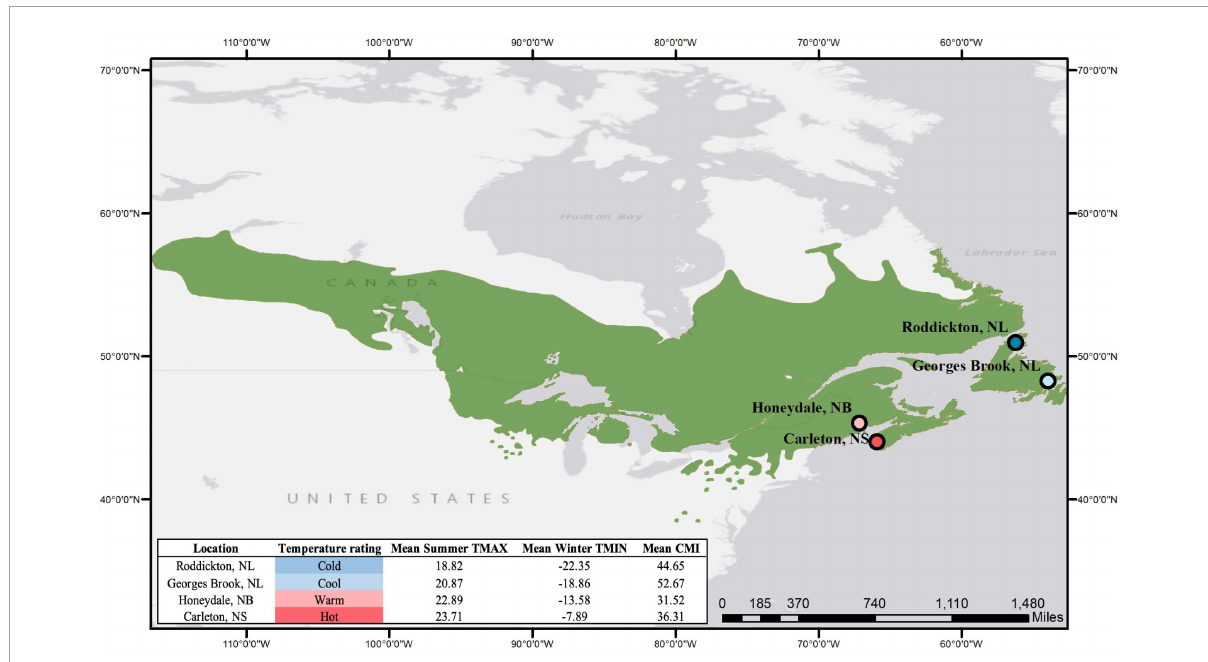
FIGURE1 Balsam fir provenance locations overlayed with the geographic extent of the species (Little, 1971), accompanied with their corresponding climate values.